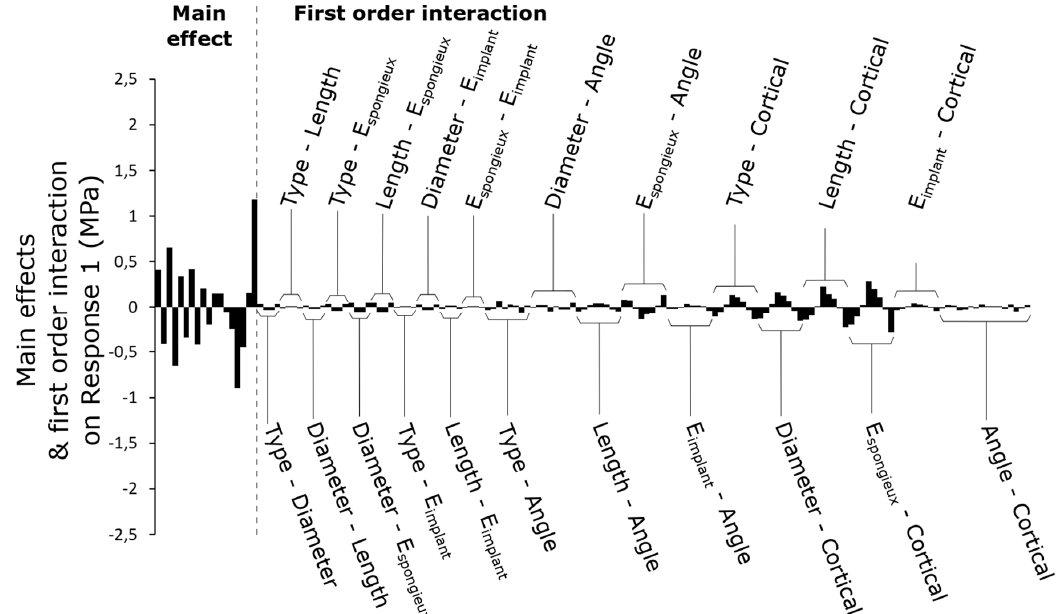
Figure 5. Main effects and first-order interactions between parameters on Response 1. Figure 5. Main e ff ects and first-order interactions between parameters on Response 1.